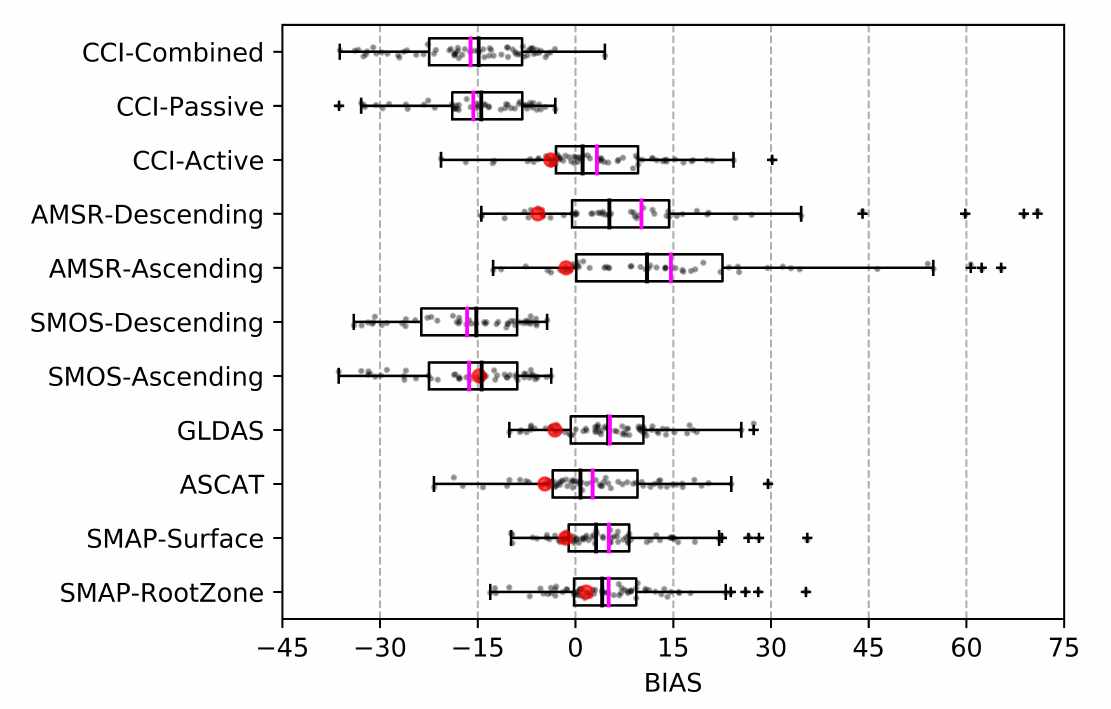
Figure 7. Box and whisker plots showing bias values between the satellite products and the CRNP’s in the COSMOS database. Red points show the results for Çakıt Basin CRNP , pink lines show the mean values and + signs depict